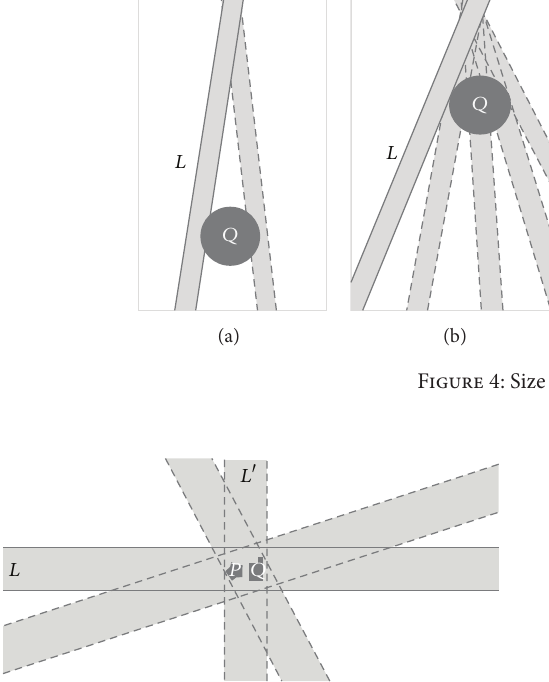
Figure 5: P and Q are indiscernible for L